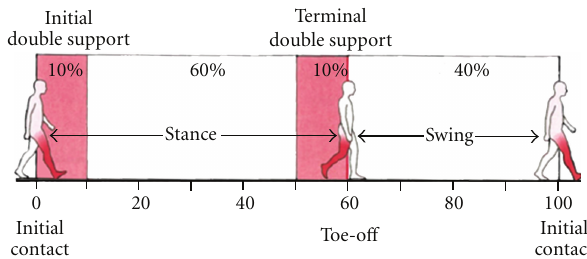
Figure 3: The gait cycle has two periods of double support, where both feet are weight-bearing. Reprinted with permission: Elsevier Books